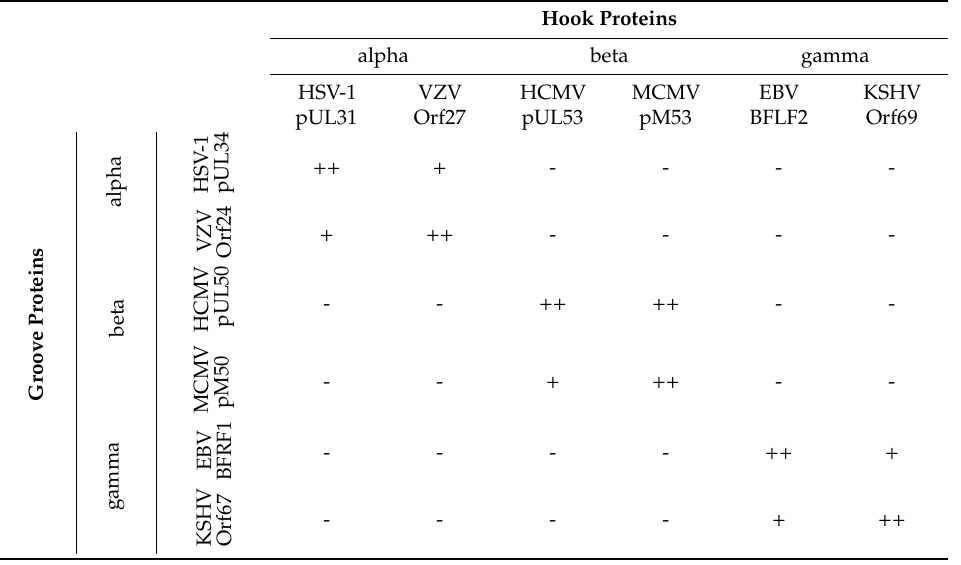
Table 2. Autologous and nonautologous patterns of core NEC protein nuclear rim colocalization: selected examples derived from α -, β - and γ - Herpesvirinae . Various combinations of NEC interactions were analyzed on the basis of pairwise transient cotransfection of NEC-encoding expression plasmids, i.e., α -herpesviral pUL34 / Orf24, pUL31 / Orf27 (HSV-1 / VZV); β -herpesviral pUL50 / pM50, pUL53 / pM53 (HCMV / MCMV); γ -herpesviral BFRF1 / Orf67, BFLF2 / Orf69 (EBV / KSHV). Confocal microscopic evaluation of rim-like nuclear envelope colocalization of autologous / nonautologous core NEC pairs, transiently coexpressed in HeLa cells. Localization phenotypes: -, colocalization in < 5% of cells; ±